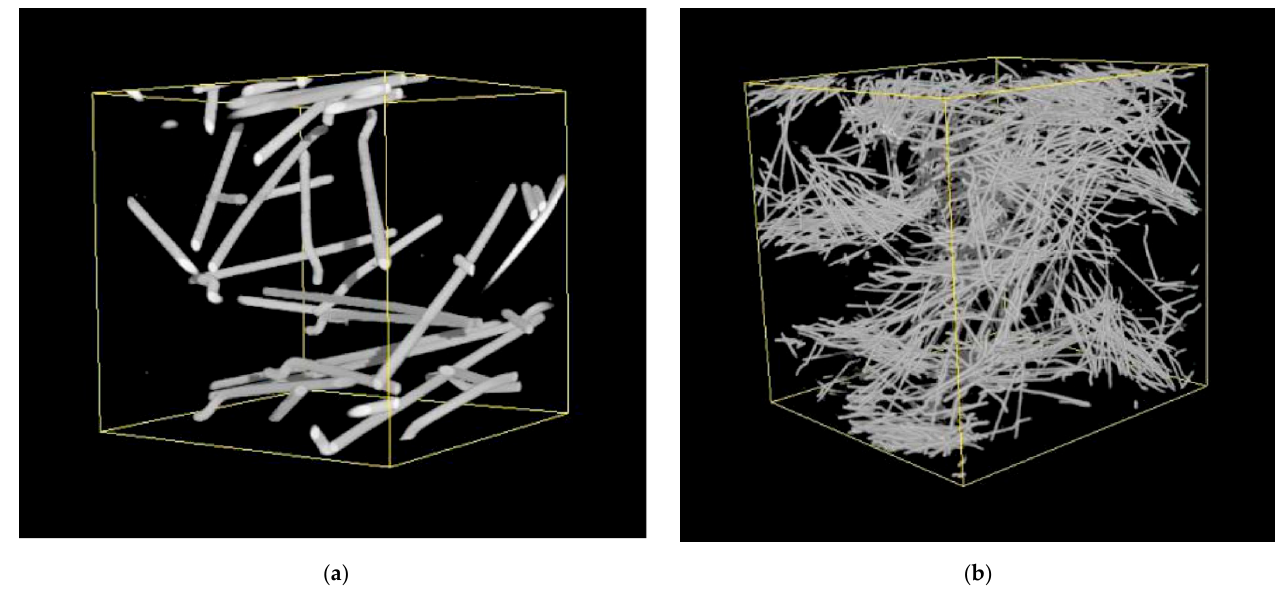
Figure 2. Fibre volumetric distribution in concrete specimens ( a ) containing steel fibres with length of 60 mm; ( b ) containing steel fibres with length of 13 mm [14]. of 60 mm; ( b ) containing steel fibres with length of 13 mm